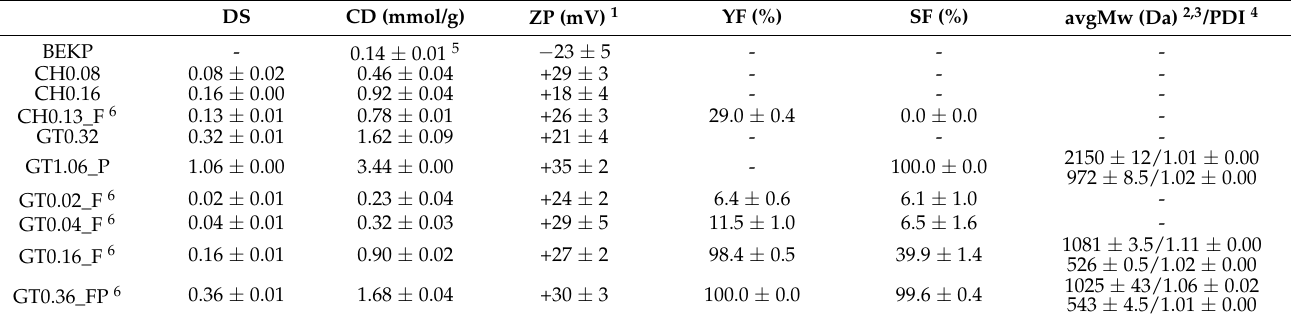
Table 2. Characterization of the original BEKP and celluloses cationized with CHPTAC and